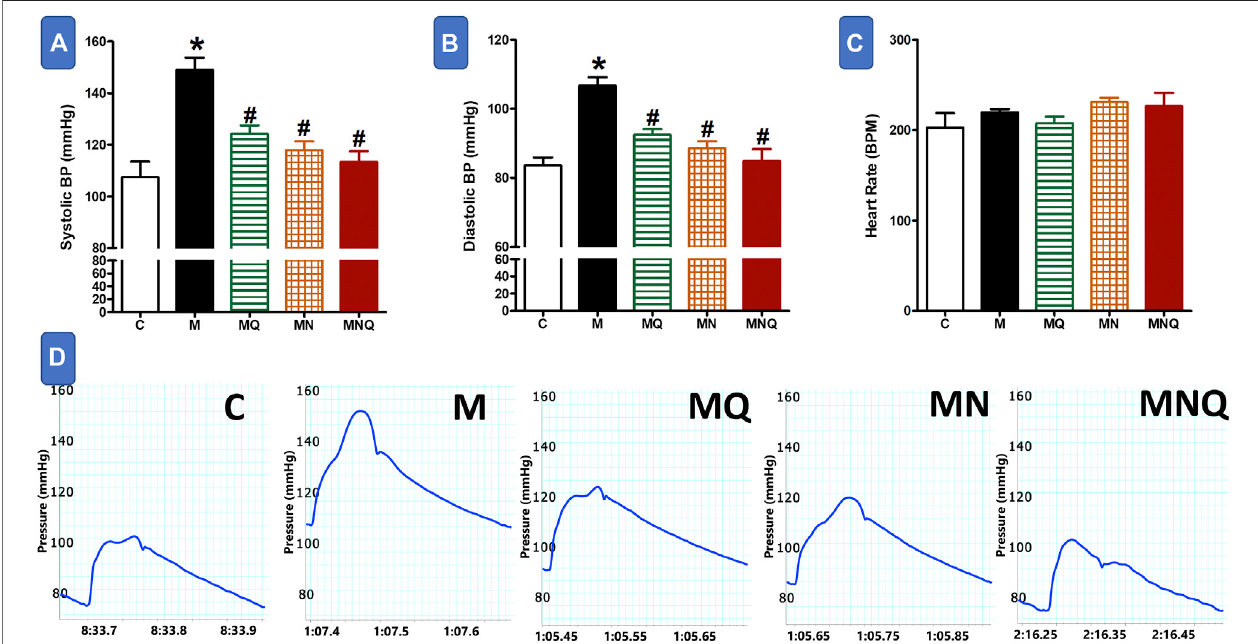
FIGURE 3 | Effect of oral administration of standard quercetin suspension (MQ), plain nano-pharmaceutical formulation (MN) and the quercetin loaded nano- pharmaceutical formulation (MNQ) both at 83 μ mol/kg/day on systolic BP (A) , diastolic BP (B) and heart rate (C) in metabolic syndrome (M) induced by feeding rats a high fructose (10% in drinking water), high salt (3%) and high fat (25%) diet for 12 weeks. Panel D shows representative original recording of arterial hemodynamics. Results are expressed as mean ± SEM (n (cid:2) 8 for all groups). * p < 0.05 when compared to the corresponding control (C) values, # p < 0.05 when compared to the corresponding MetS values using one-way ANOVA followed by Dunnet ’ s post-hoc